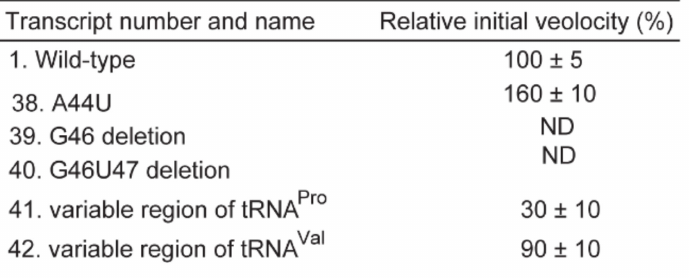
Figure 7. ( A ) tRNA transcripts with a short variable region are not methylated by Trm11-Trm112. Mutations were introduced into the variable region of wild-type tRNA Phe transcript. In the case of transcript 38, A44 in the tRNA Phe transcript was substituted by U. Transcripts 39 and 40 are deletion mutants of the tRNA Phe transcript. In the case of transcripts 41 and 42, the variable region (AGGUC) of tRNA Phe was substituted by the variable region of tRNA Pro (AGGCC) and tRNA Val AAC (ACGUC), respectively. ( B ) The initial velocity of methyl-transfer to the wild-type tRNA Phe transcript is expressed as 100%. The data in this figure are averages of the results from four independent experiments. “ND” means that methyl-transfer was not